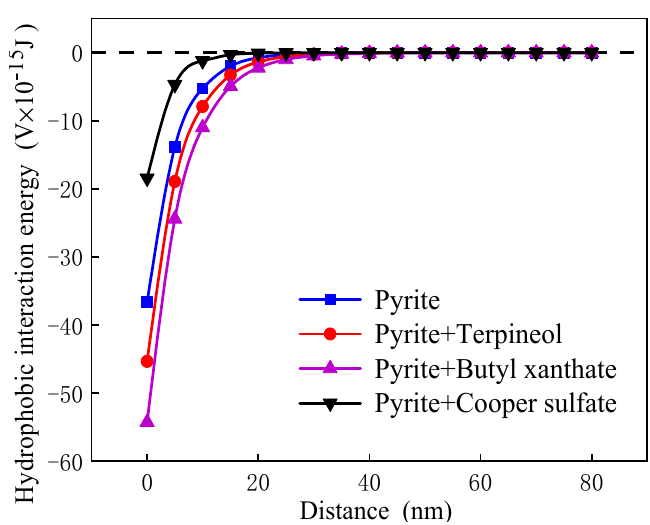
Figure 11. The hydrophobic interaction energy between pyrite particles.